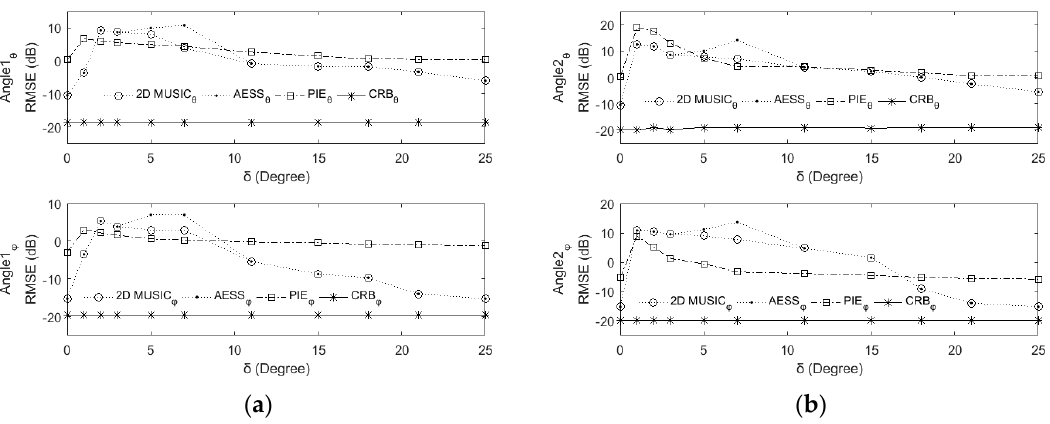
Figure 10. RMSE and CRB versus source separation. ( a ) RMSE of the first source; ( b ) RMSE of the second source.